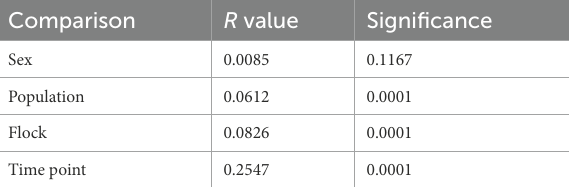
TABLE 2 Analysis of similarity (ANOSIM) results of junco preen gland microbial communities comparing sex, populations (sub-species), flock, and time